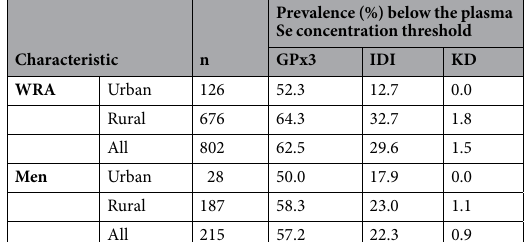
Men Urban 28 50.0